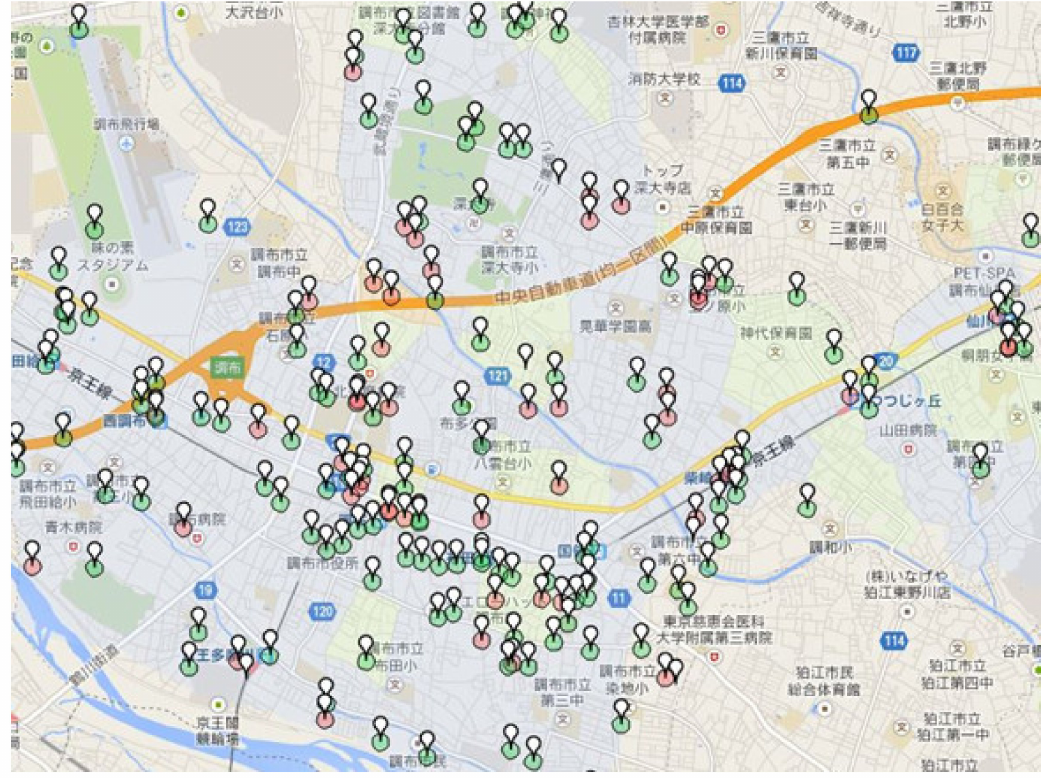
Figure 4. Distribution of information submitted to the social media GIS for disaster information